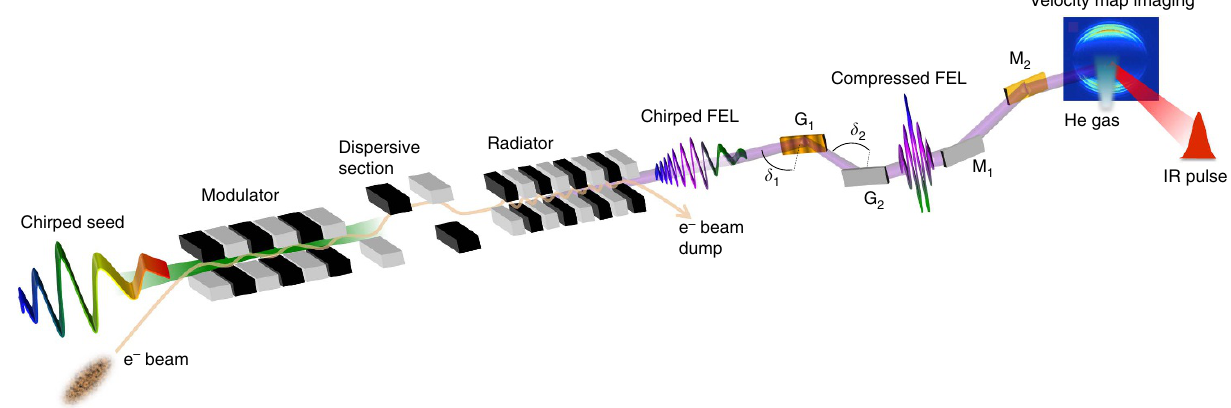
Figure 1 | Scheme of a seeded free-electron laser in CPA mode. When operated in CPA regime, the FEL is seeded with a Gaussian laser pulse carrying a linear frequency chirp. The seed interacts with electrons in a short undulator (the modulator). The resulting electron-beam energy modulation is transformed into a density modulation (bunching) when the electrons cross the magnetic field generated by a dispersive section. The bunching has a significant harmonic content at the frequency of the seed, o seed , and at its harmonics. Finally, the modulated electrons are injected into a long undulator (the radiator), which is tuned to the n th harmonic of the seed. In the radiator, electrons emit coherently at the frequency o FEL ¼ n o seed . Under proper conditions, the frequency chirp of the seed is transmitted to the FEL harmonic pulse generated at the end of the radiator and can then be compensated by an optical compressor. The compressor includes four optical elements: two gratings (G1 and G2) in classical diffraction geometry and two plane mirrors (M1 and M2), which steer the beam back to its original propagation axis. After the exit of the compressor, the FEL beam is directed towards the experimental chamber of the FERMI Low Density Matter beamline (see: http://www.elettra.eu/lightsources/fermi/fermi-beamlines/ldm/ldmhome- page.html) where the FEL pulse duration is measured using a cross-correlation scheme. In the latter, the atoms of a He gas are photo-ionized by the FEL, assisted by a synchronized infrared laser pulse (see Fig. 2). A raw image is shown of a He photo-electron distribution acquired with a VMI